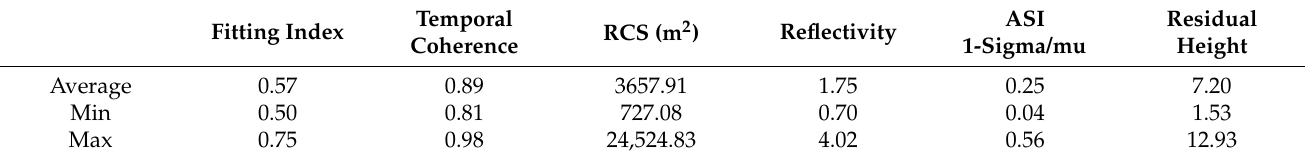
Table 5. Classification criteria statistics.